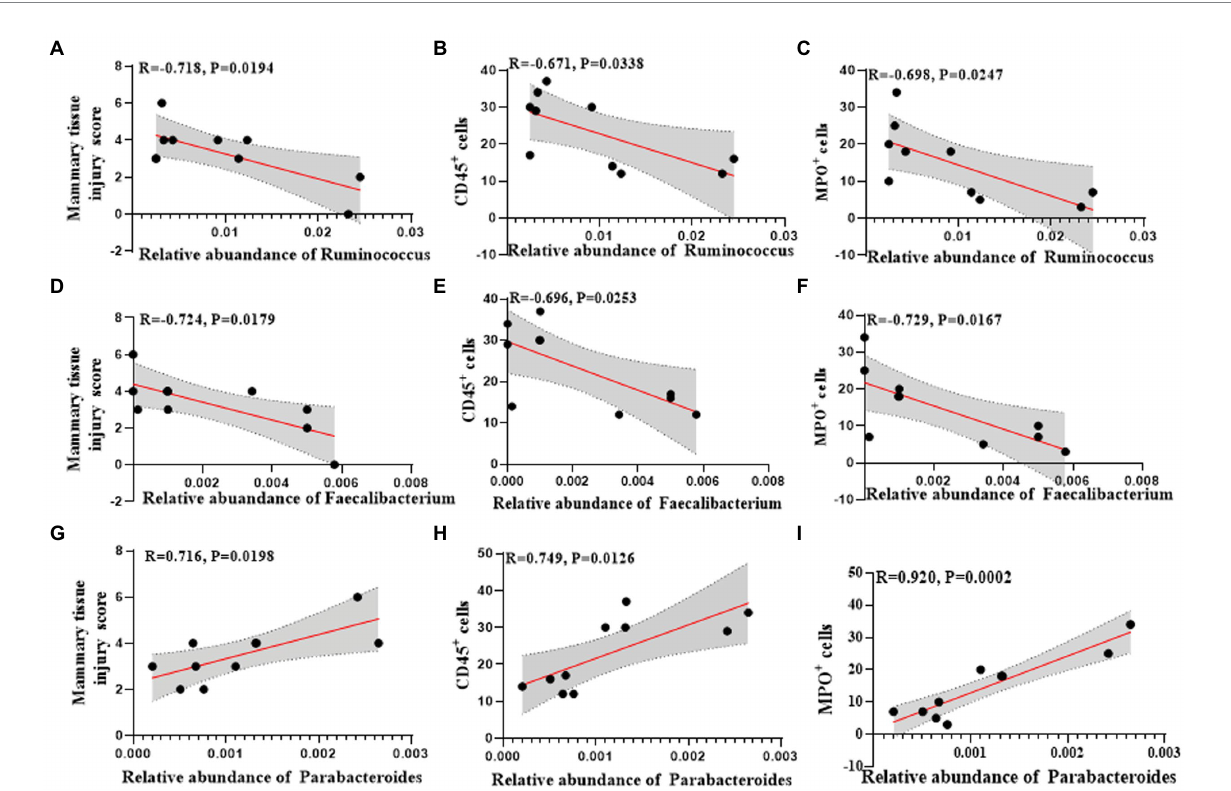
FIGURE 6 Univariate linear regression between Ruminococcus , Faecalibacterium and Parabacteroides relative abundance in fecal samples and mammary tissue injury score, CD45 + cells and MPO + cells of the matched mice. (A) Spearman correlation between Ruminococcus and mammary tissue injury score. (B) Spearman correlation between Ruminococcus and CD45 + cells. (C) Spearman correlation between Ruminococcus and MPO + cells. (D) Spearman correlation between Faecalibacterium and mammary tissue injury score. (E) Spearman correlation between Faecalibacterium and CD45 + cells. (F) Spearman correlation between Faecalibacterium and MPO + cells. (G) Spearman correlation between Parabacteroides and mammary tissue injury score. (H) Spearman correlation between Parabacteroides and CD45 + cells. (I) Spearman correlation between Parabacteroides and MPO +